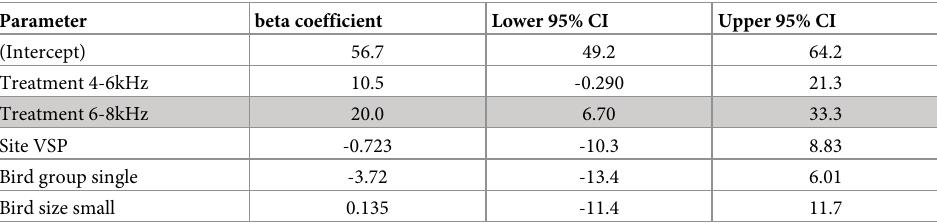
Table 6. Overall angle of displacement model-averaged parameter